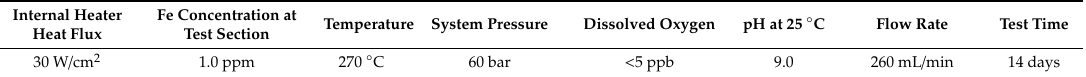
Figure 4. A schematic of the circulation secondary loop system for magnetite deposition test. Table 2. Main conditions for the magnetite deposition